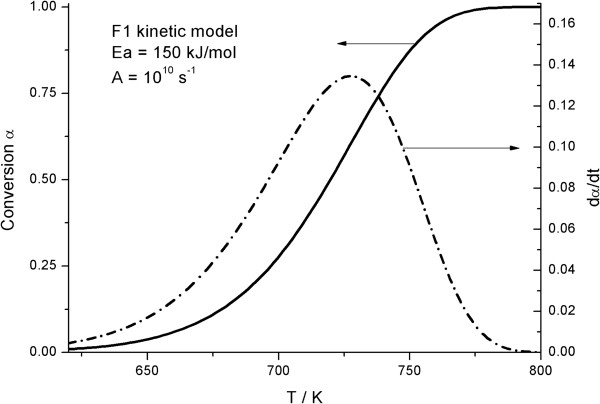
Kinetic curve simulated according the following kinetic parameters: Ea=150 kJ/mol, A=1010 s-1, and a F1 kinetic model.